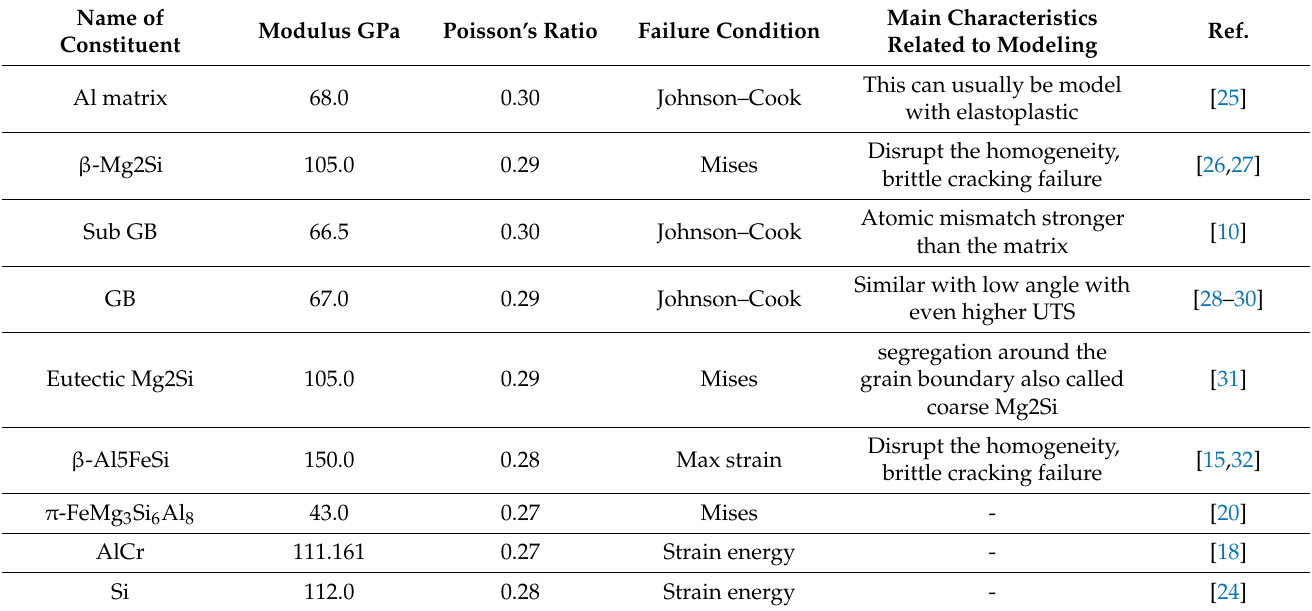
Table 4. Constituents considered in the FEA